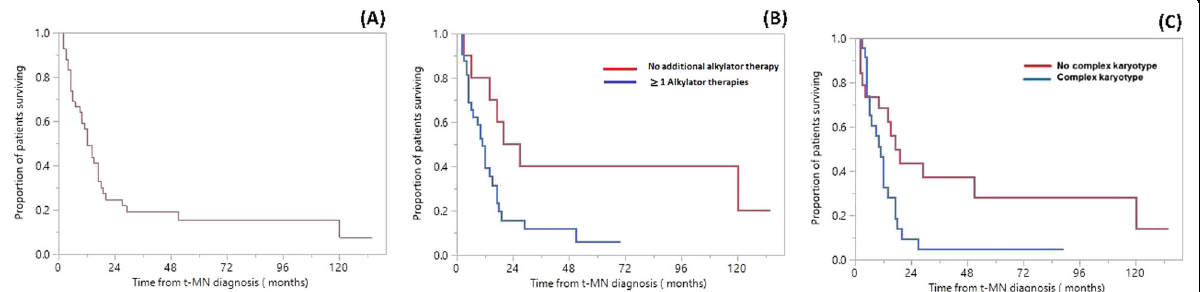
Fig. 1 Survival of multiple myeloma (MM) patients that underwent autologous SCT and developed therapy-related myeloid neoplasm (t-MN). A Overall survival following t-MN diagnosis; B Overall survival following t-MN diagnosis for patients that received ≥ 1 cycle of alkylator therapy compared to those who received no additional alkylator therapy; C Overall survival following t-MN diagnosis for patients with a complex karyotype (CK) compared to those without